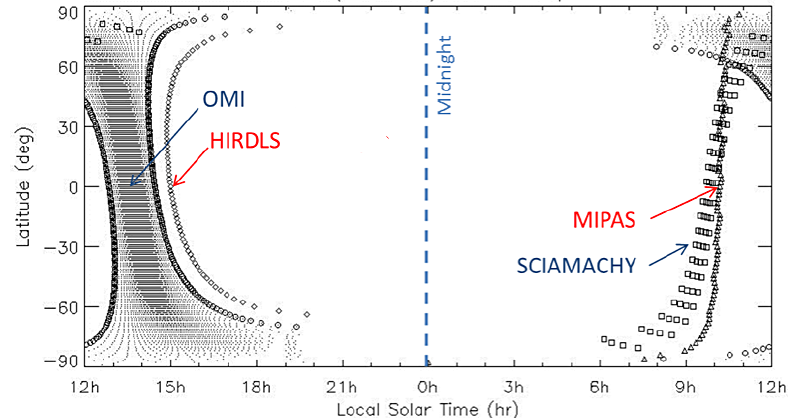
Figure 3. Daytime local solar times (LST) for different satellite observations: OMI and HIRDLS fly on the same EOS Aura platform, yet their viewing geometries result in different local solar times. The same occurs to MIPAS and SCIAMACHY on ESA’s ENVISAT.